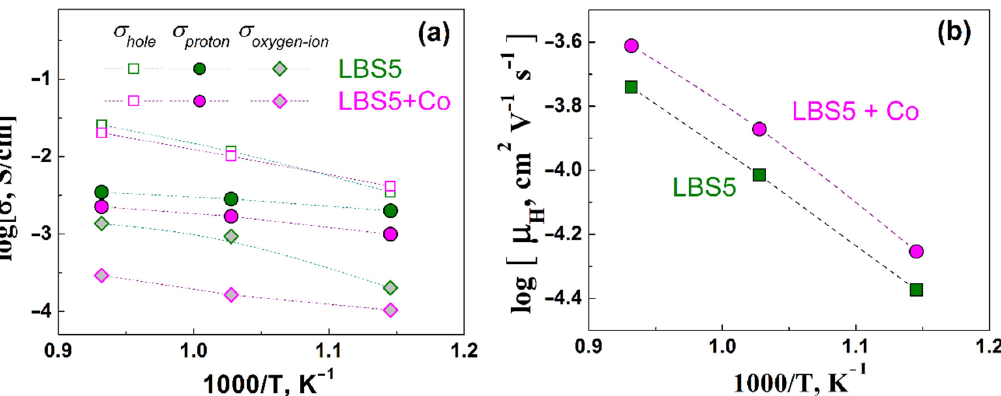
Figure 12. Temperature dependences of the proton, hole, and oxygen ion partial conductivities ( a ) and proton mobilities ( b ) of La 0.95 Ba 0.05 ScO 3- δ and La 0.95 Ba 0.05 ScO 3- δ + 0.5 wt% Co 3 O 4 samples.